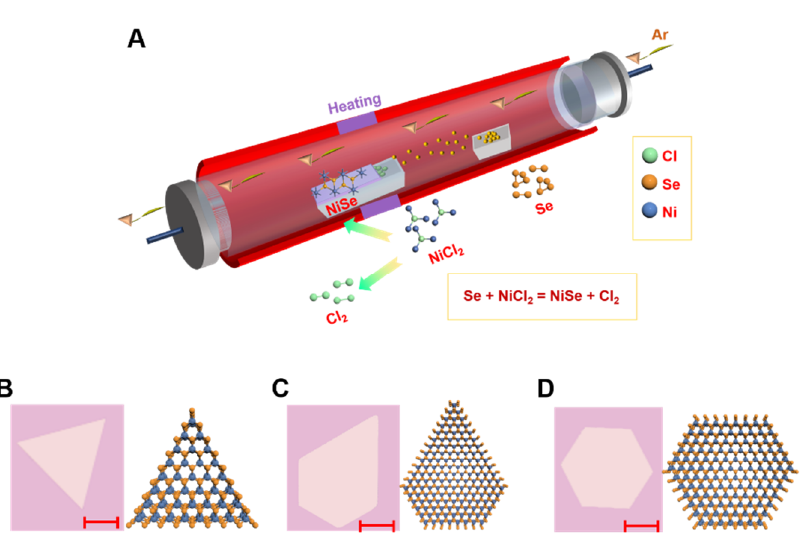
Figure 1. The growth of NiSe flakes with a chemical vapor deposition (CVD) method. ( A ) Schematic of the CVD setup for NiSe synthesis. The precursors are NiCl 2 and Se powers. ( B ) The optical image and corresponding atomic structure image of triangle-like NiSe flake. ( C ) The optical image and corresponding atomic structure image of pentagon-like NiSe flake. ( D ) The optical image and corresponding atomic structure image of hexagon-like NiSe flake. The scale bar is 10 um.